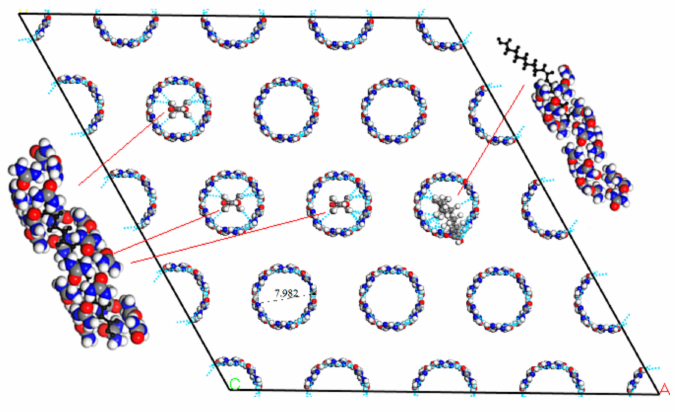
Figure 6. Hexagonal holes framework of urea